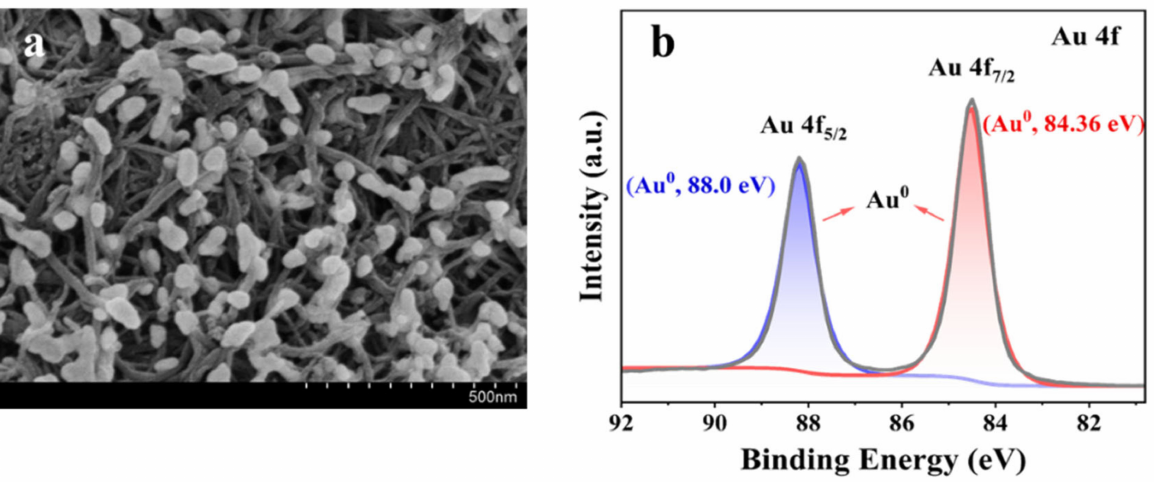
Figure 2. Preparation and characterization of the CNT-MoS 2 @Au catalytic membrane. ( a ) FESEM image and ( b ) high resolution Au 4f XPS spectrum of CNT-MoS 2